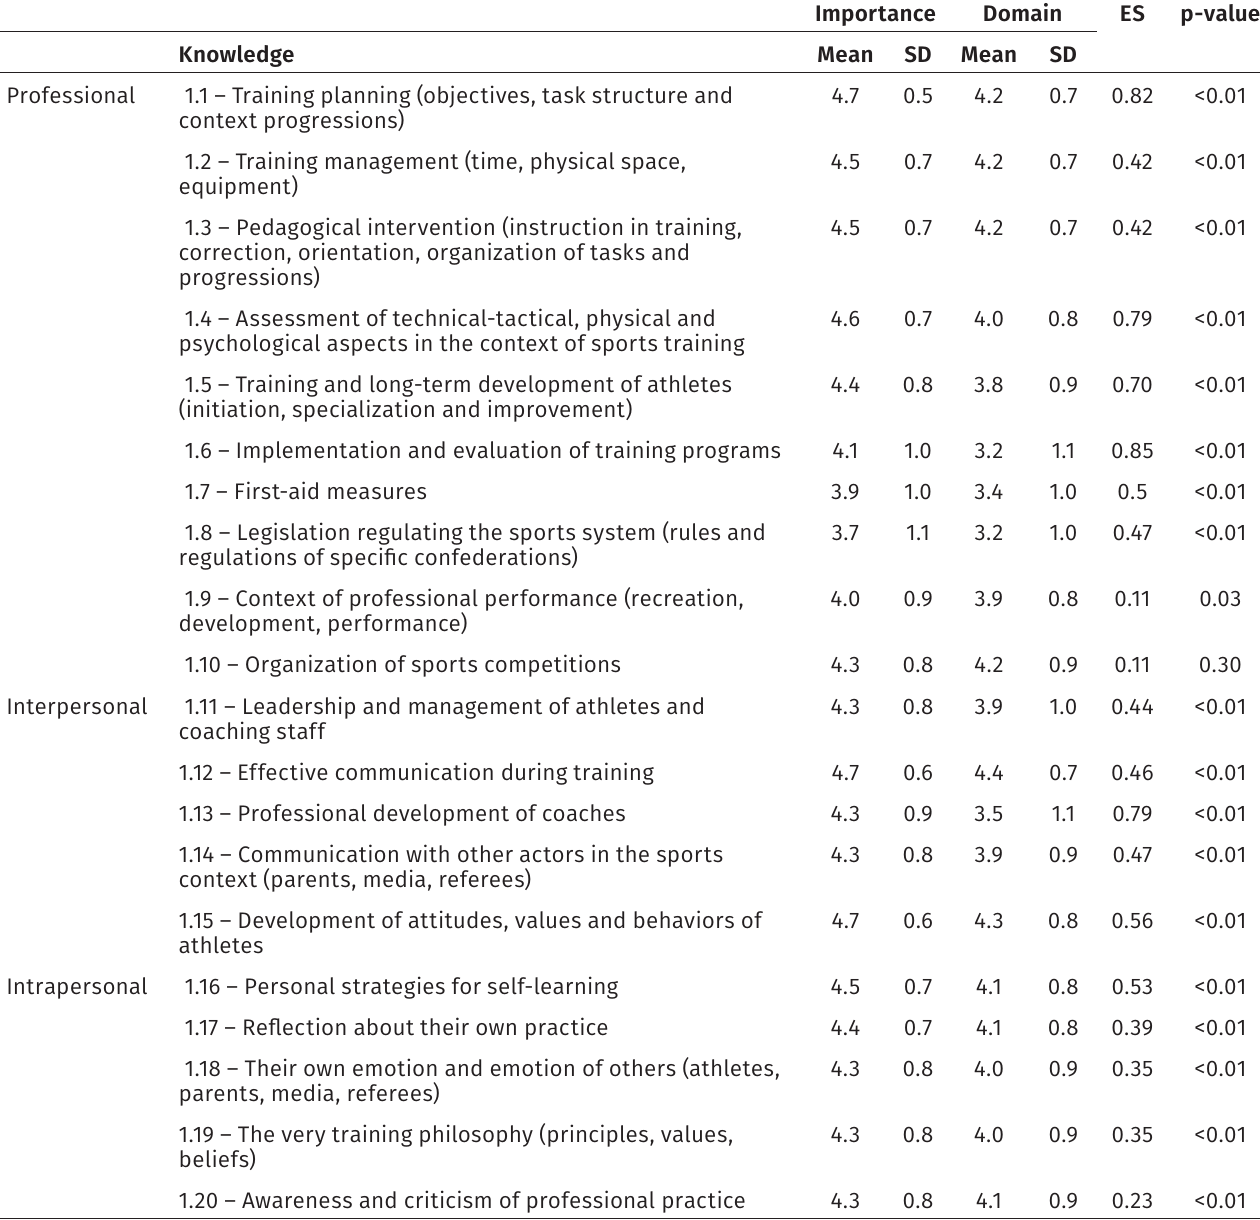
Attributed importance and perceived domain about the knowledge of racket sports coaches.